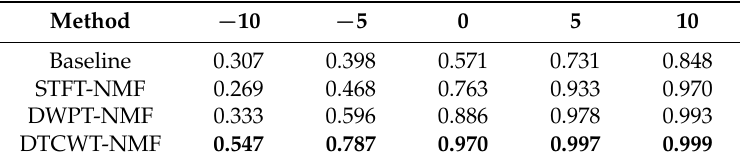
Table 2. The HASPI results in five SNR cases.